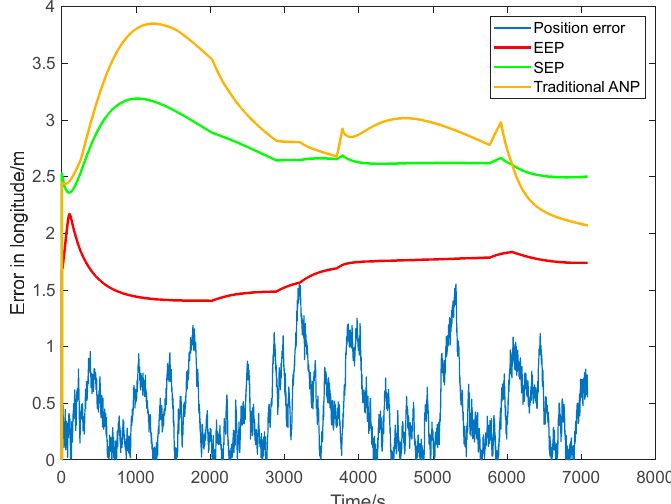
Figure 13. Comparison between longitude position error and ANP.